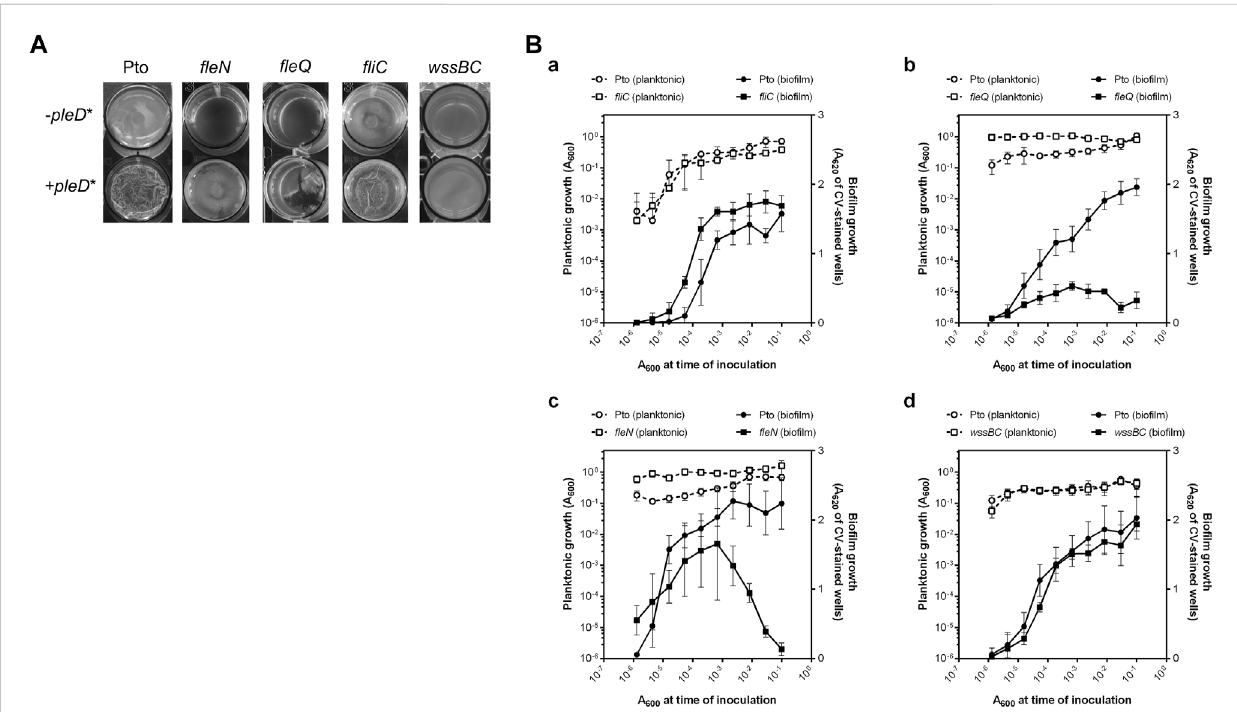
FIGURE 1 Bio fi lm development by Pto DC3000 mutant strains. (A) Air-liquid bio fi lm formation. Pto and the fl iC , fl eQ , fl eN and wssBC mutants were grown underaerobicandstaticconditionsat20 ° Cin24-multiwellplatesfor72 hinMMR supplementedwithtetracycline(10 μ g/ml),whenimagesweredirectly taken from the plate. (B) Solid-liquid bio fi lm formation. Serial dilution-based growth curves of the indicated strains where planktonic (left axes, open symbols) or bio fi lm growth (right axes, closed symbols) is plotted against the initial A 600 of each dilution. Circles represent the wild type strain and squares represent the fl iC (a) , the fl eQ (b) , the fl eN (c) and the wssB (d) mutants. Plots display one representative experiment of at least three biological replicates. Error bars represent the standard deviation of the eight technical